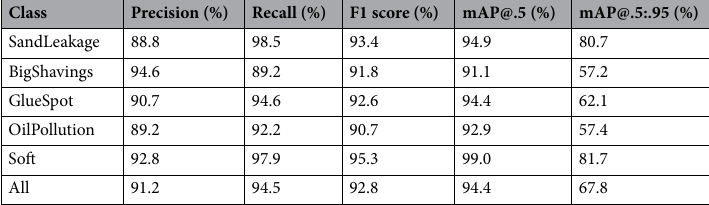
Table 4. Identification results of particleboard surface defects.